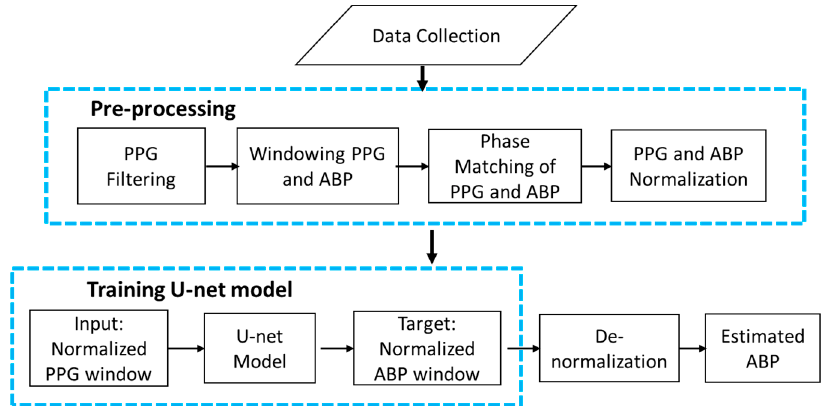
Figure 4. Flow chart of the overall architecture.